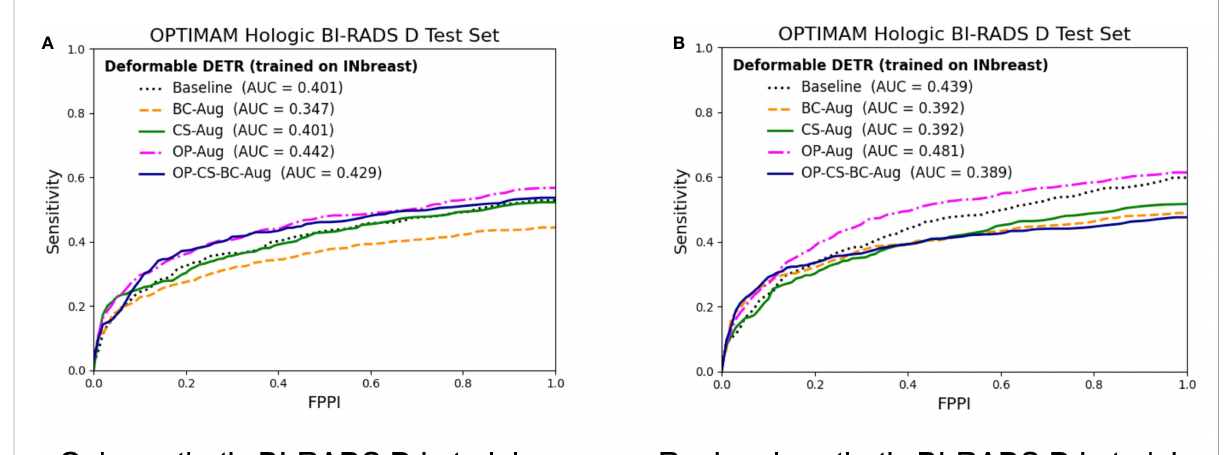
FIGURE 7 FROC curves for the mass detection models trained using INbreast dataset. The baseline model did not include synthetic data augmentation in the training. The BC-Aug , CS-Aug and OP-Aug and the OP-CS-BC-Aug models only used synthetic images from the corresponding CycleGAN models. (A) The OPTIMAM Hologic test set contained 120 BI-RADS D mammograms with annotated masses. (B) The models were trained with 8 additional real BI-RADS D mammograms. (For interpretation of the references to color in this fi gure legend, the reader is referred to the web version of this article.).